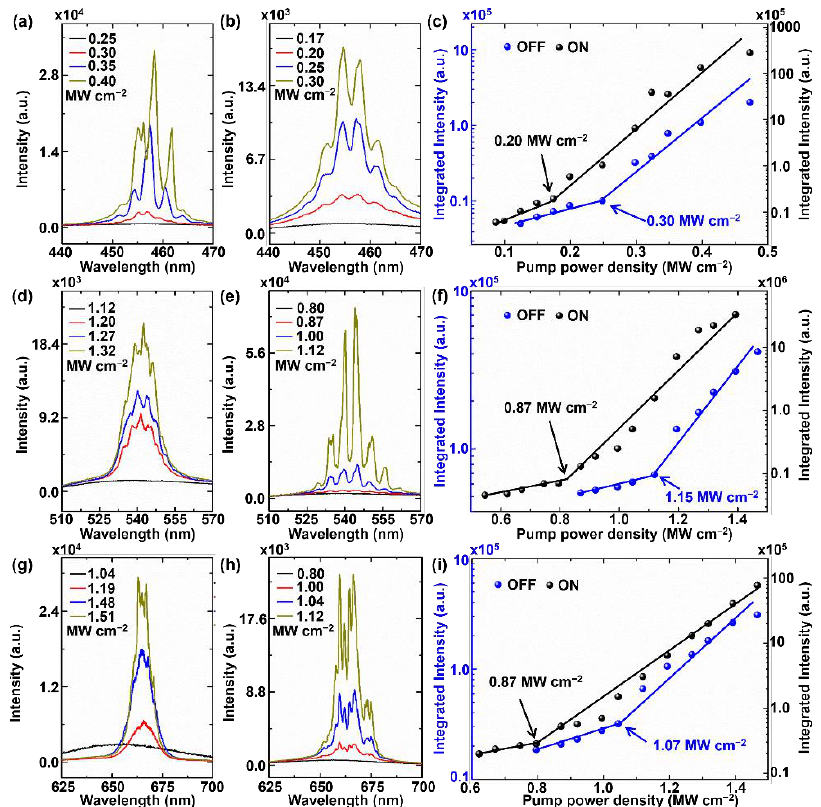
Figure 2. Performance characterization of the random lasers. ( a , b ) The emission spectra of RL B at different pump power densities when the electric field is removed ( a ) and applied ( b ). ( c ) The integral intensity varies with pump power density for RL B . ( d , e ) The emission spectra of RL G at different pump power densities when the electric field is removed ( d ) and applied ( e ). ( f ) The integral intensity varies with pump power density for RL G . ( g , h ) The emission spectra of RL R at different pump power densities when the electric field is removed ( g ) and applied ( h ). ( i ) The integral intensity varies with pump power density for RL R . The corresponding spectral integral range is from 440 nm to 470 nm for RL B , from 510 nm to 570 nm for RL G and from 625 nm to 700 nm for RL R .